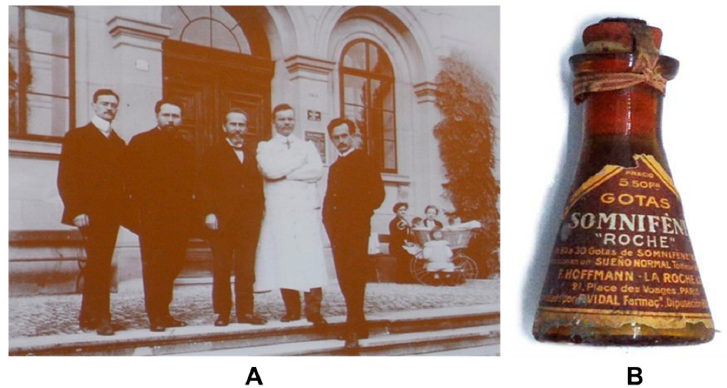
Figure 4. Jakob Klaesi (right) (1883–1980) with the Burghölzli Hospital psychiatric staff, including its director, Eugen Bleuler (centre), in a photograph taken around 1910 ( A ) and a container of Somnifen drops of the first third of the century 20th century, commercialized in Spain by F. Hoffmann-La Roche & Cie, Paris ( B ).